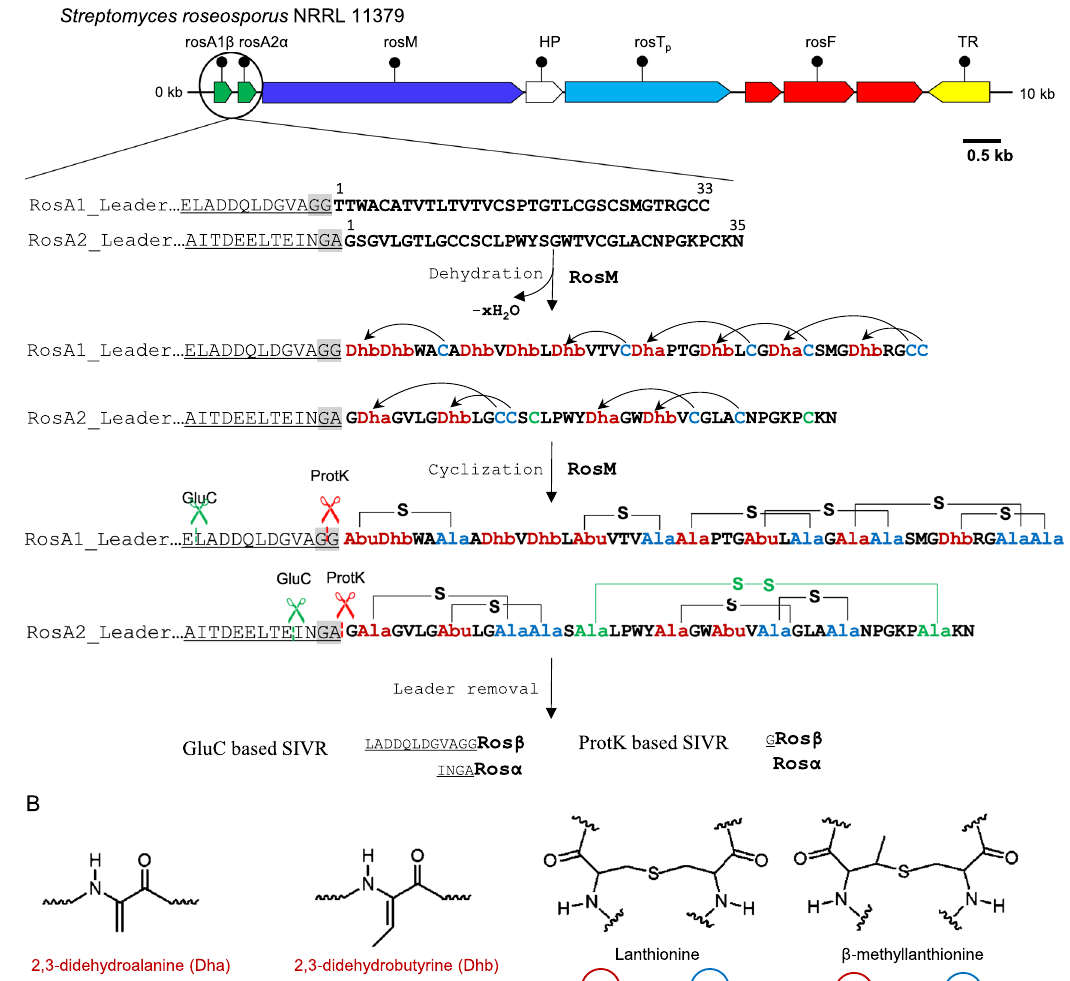
Fig. 1 Biosynthesis of the two-component lantibiotic roseocin. A Roseocin is constituted of two precursor peptides, RosA1β and RosA2α, which are post-translationally modified by RosM in two steps (dehydration followed by cyclization). This is followed by leader removal in vitro using commercially available proteases like endoproteinase GluC or proteinase K (Singh et al. 2020). The ring topology of roseocin peptides is supported by mass spectrometry and bioinformatic analysis as per the current study. B Common PTMs in the biosynthesis of lanthipeptide involves the dehydration of serine and threonine amino acid residues to 2,3-dehydroalanine (Dha) and 2,3-dehydrobutyrine (Dhb), respectively. Michael-type addition of Cys to Dha leads to lanthionine (Lan), while addition to Dhb results in a methyllanthionine (MeLan) ring. Abu aminobutyrate, Ala Alanine, SIVR semi-in vitro reconstitution, HP Hypothetical Protein, RosTp dual function peptidase-domain containing transporter, RosF group of immunity proteins (in red colour), TR Transcriptional